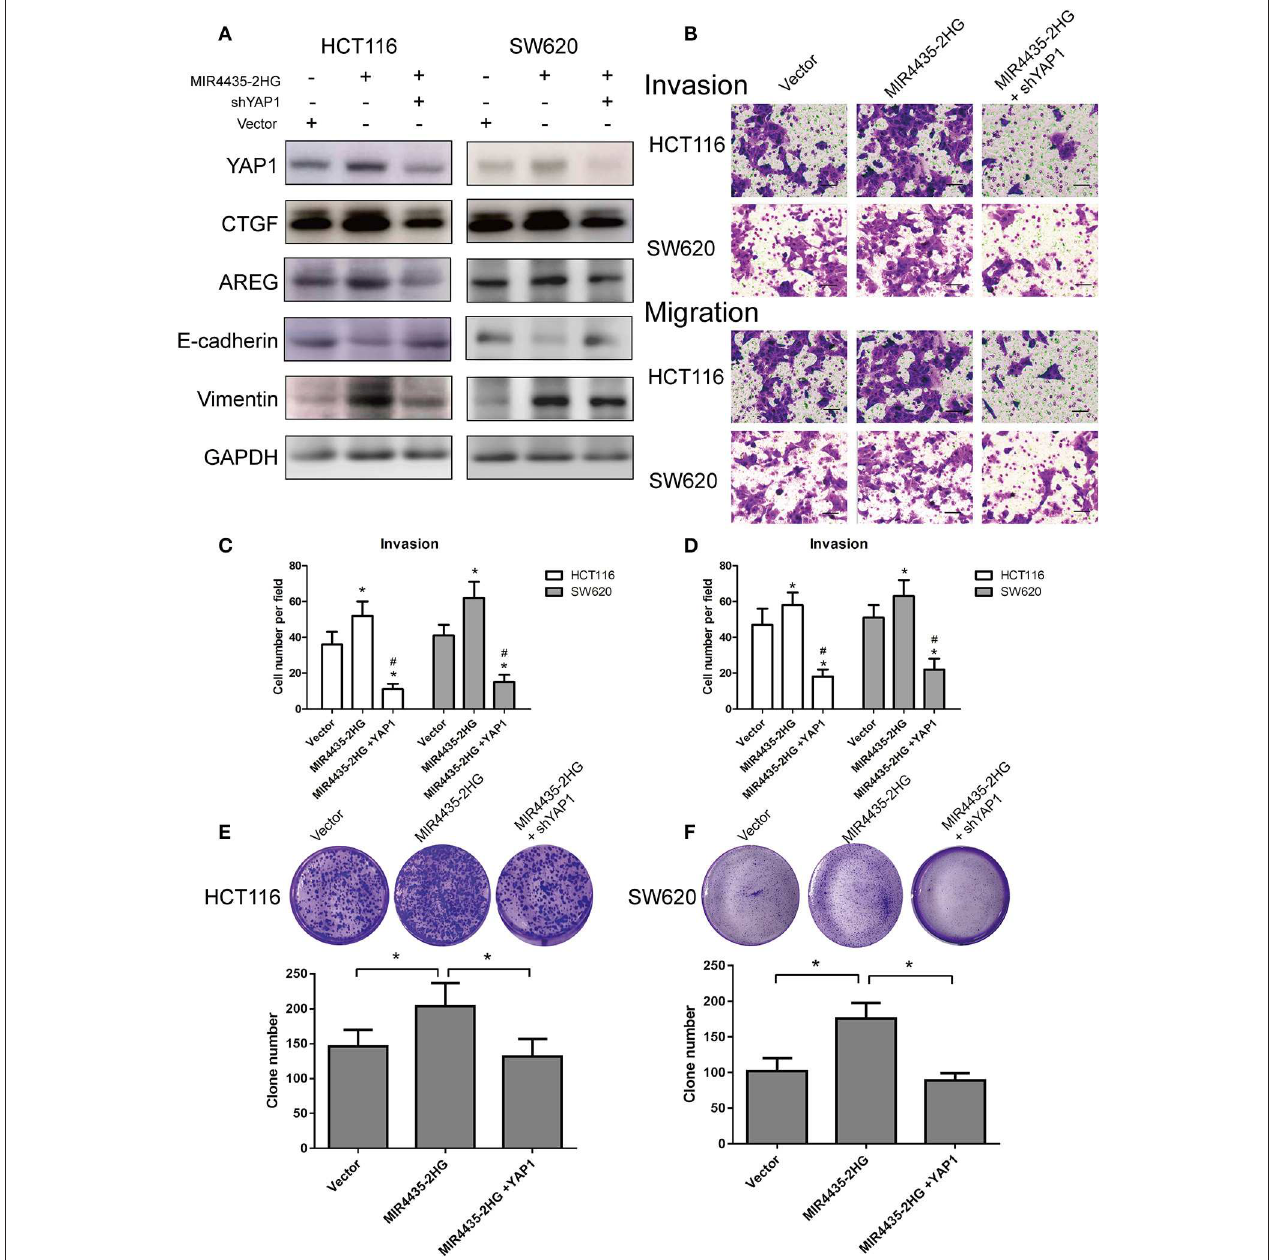
FIGURE 7 | Biological function of MIR4435-2HG is determined by YAP1. (A) Western blotting analysis of the suggested proteins in HCT116 and SW620 cells transfected with a control vector, MIR4435-2HG, or YAP1 short hairpin RNA (shRNA). GAPDH acted as a loading control. (B–D) MIR4435-2HG and YAP1 shRNA vectors underwent the transfection into HCT116 and SW620 cells and cell invasion and migration were detected using Transwell invasion and migration assays. Data are shown as mean ± SD ( n = 3). *Compared with vector P < 0.05; # compared with MIR4435-2HG P < 0.05. (E,F) Clone formation assay s were used to detect the growth of HCT116 and SW620 cells after transfection with a control vector, MIR4435-2HG, or YAP1 shRNA. Mean ± SD ( n = 3) denotes the data. * P < 0.05.